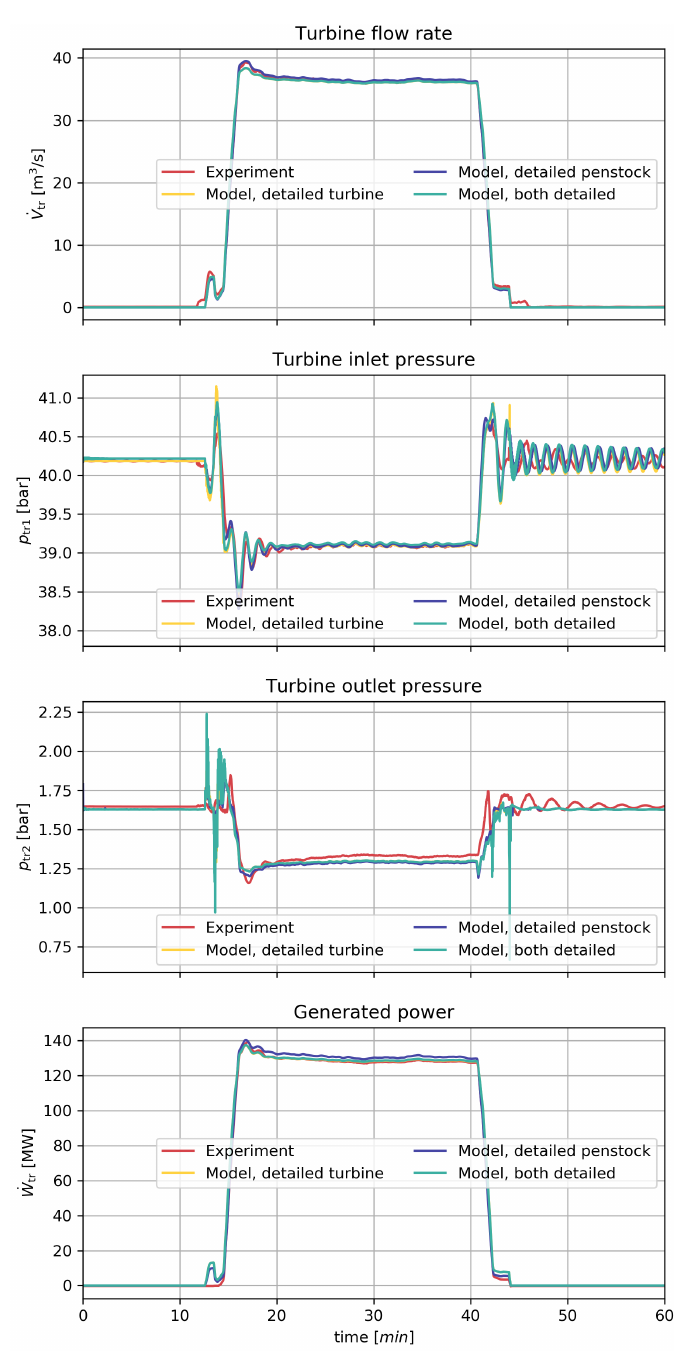
Figure 10. Comparison of the results from the detailed hydropower models and the experimental